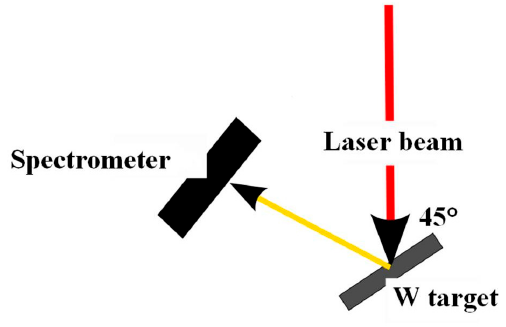
Figure 3. Experimental set-up.